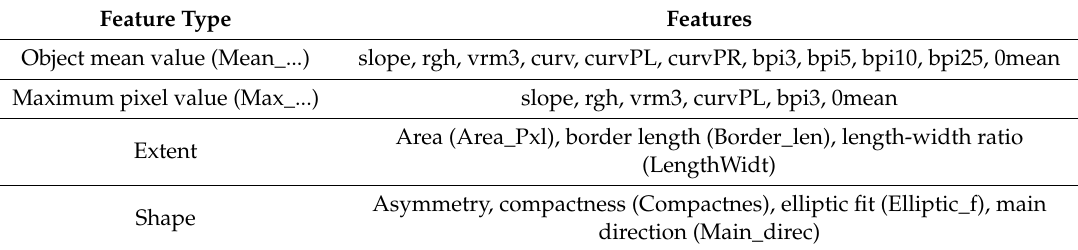
Table 2. Image-object features extracted for further analysis. Abbreviations of extent and shape features given in brackets.